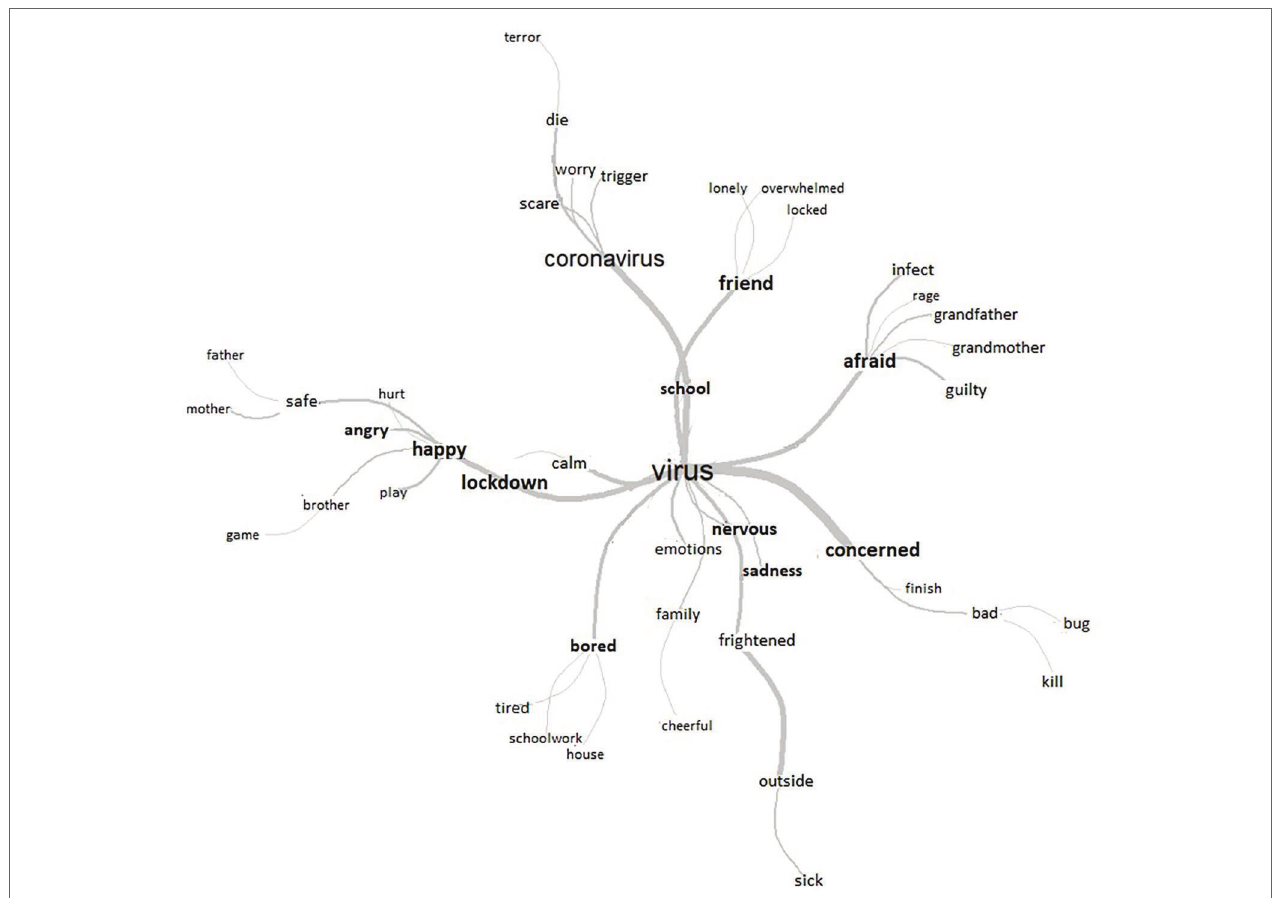
FIGURE 2 | Results of the lexical similarity analysis produced by the sub-corpus of